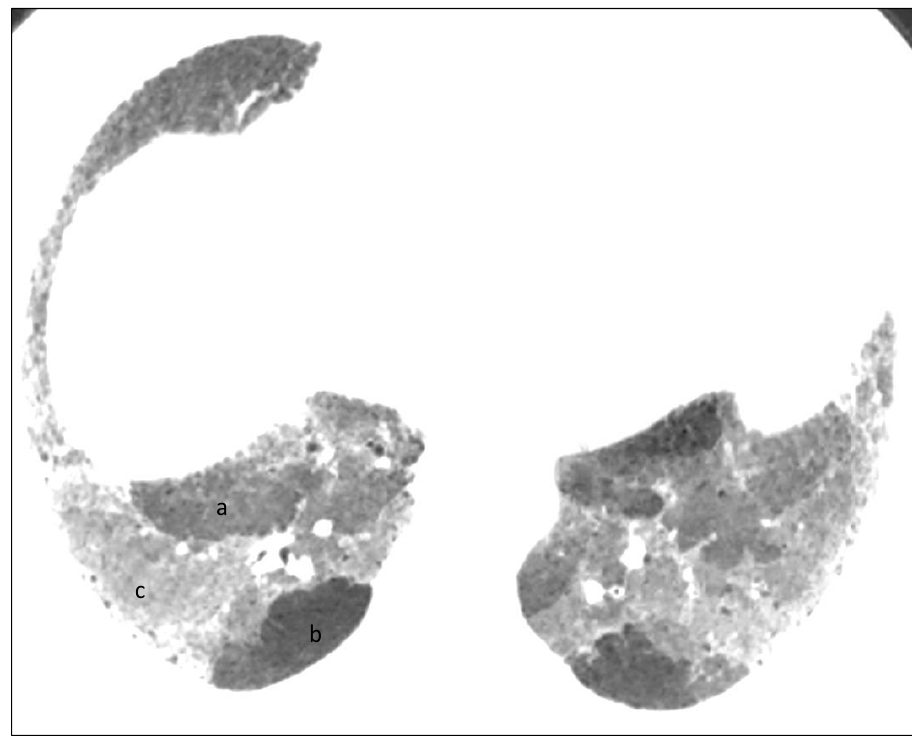
Figure 6. Axial inspiratory phase CT image shows sharply demarcated regions of three attenuations (three-density pattern): ( a ) Normal-appearing lung; ( b ) Lucent lung (i.e., regions of decreased attenuation and decreased vascularity; ( c ) High attenuation GGO.